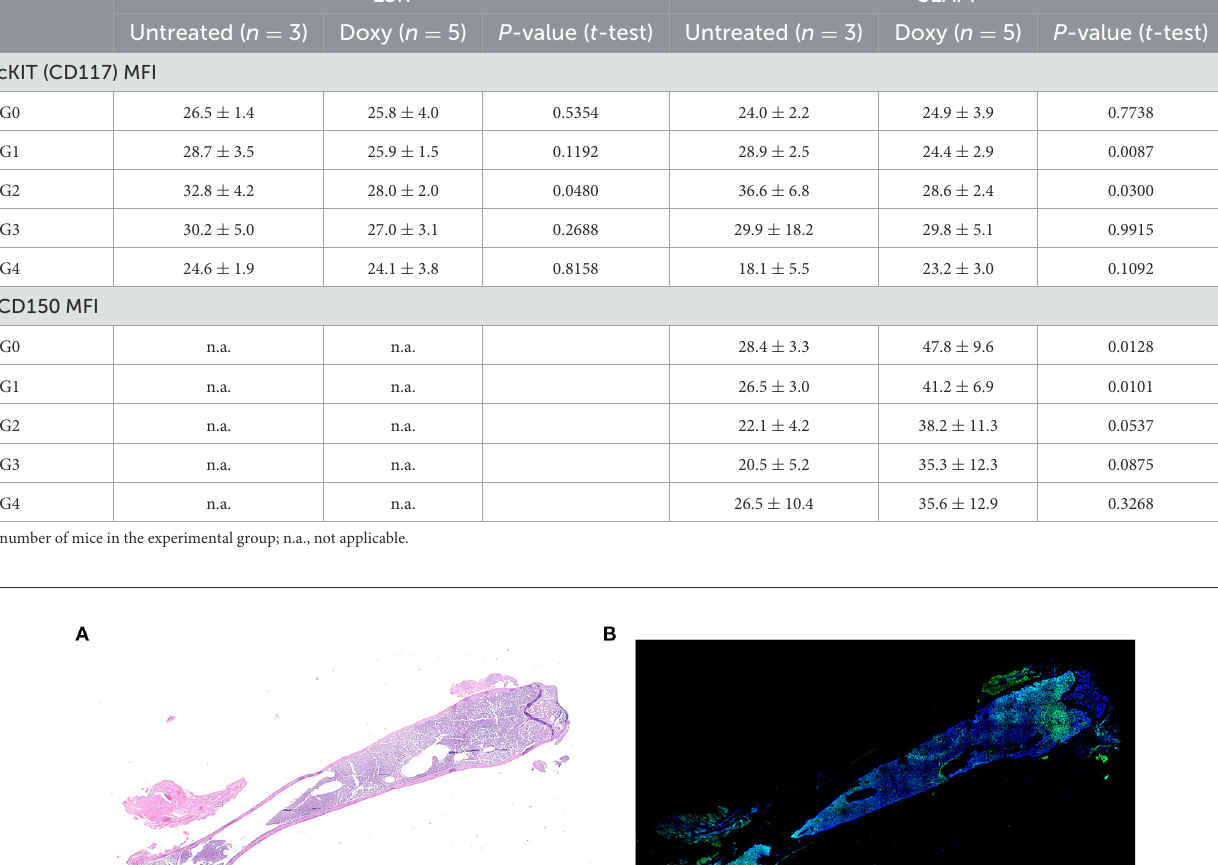
TABLE 1 Comparison of the levels of cKIT and CD150 (as mean fluorescent intensity, MFI) expressed by the LSK and SLAM cells divided for fluorescence classes presented in Figure 1. LSK SLAM